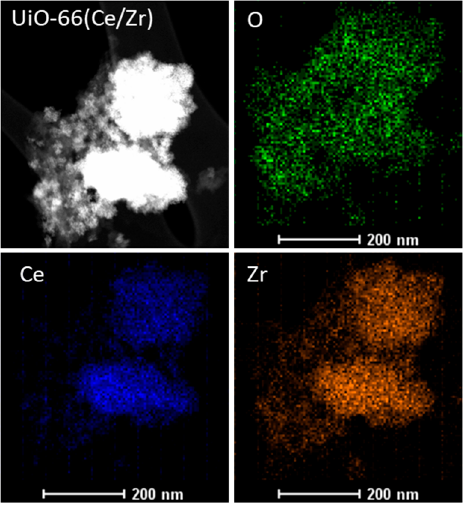
Figure 4. Scanning transmission electron microscopy (STEM) image of UiO-66(Ce / Zr) with energy dispersive X-ray spectroscopy (EDS) maps of Ce, Zr, and O.